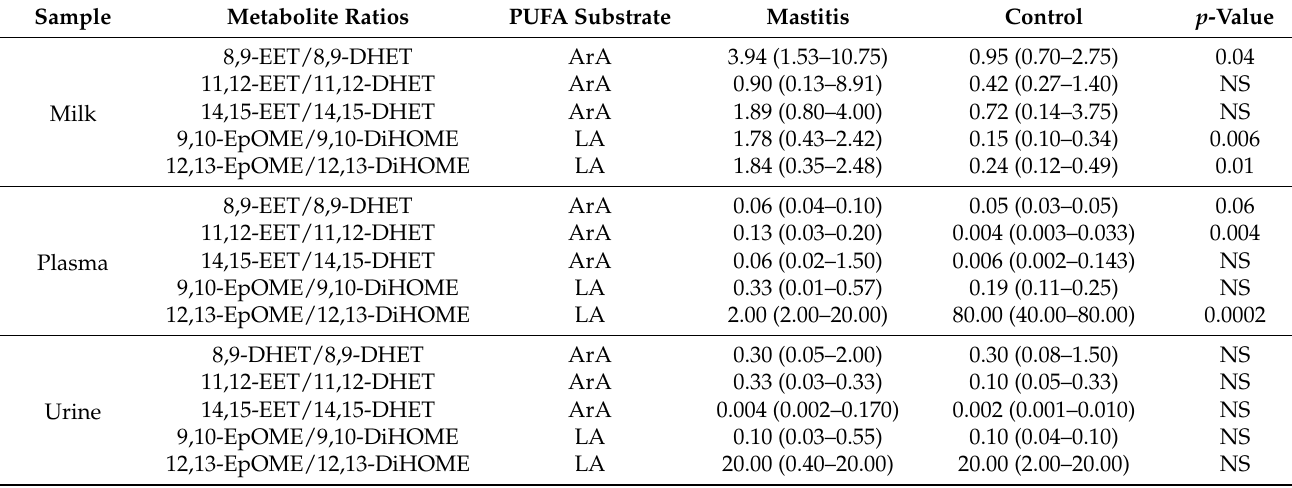
Table 4. Ratio epoxides to their sEH-derived vicinal diols in milk, plasma, and urine of systemic coliform mastitis and healthy control cows (median and range, n =